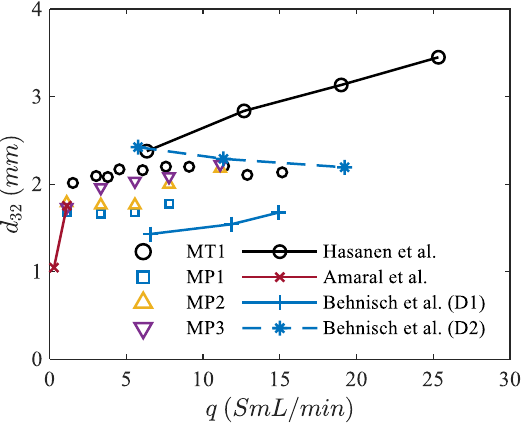
Figure 4. Sauter mean diameter of bubbles from various diffusers at different volumetric gas flow rates per opening (D1 and D2 in Behnisch et al. refer to Diffuser 1 and Diffuser 2 in the reference [11] ).